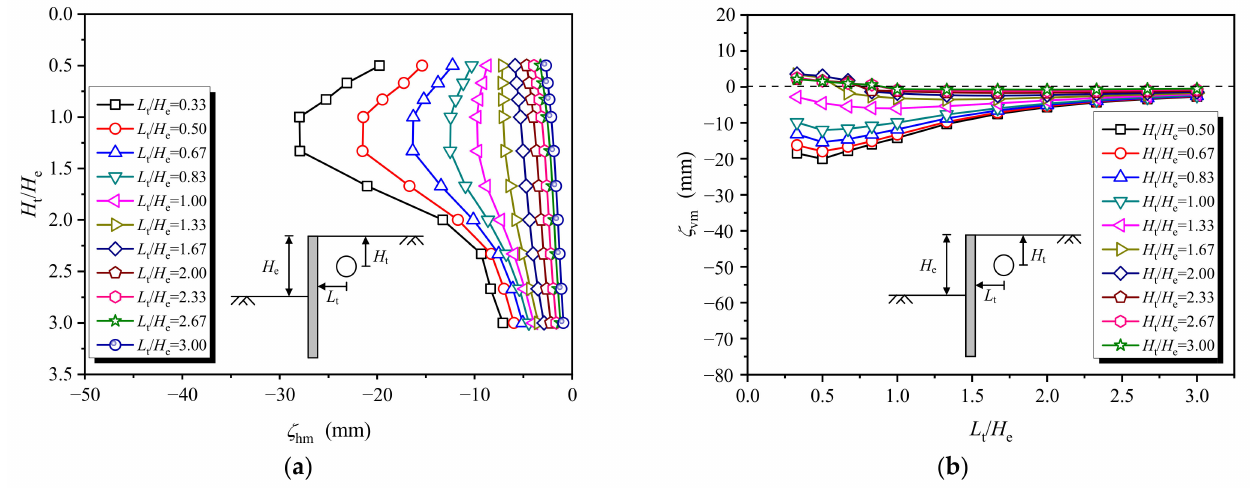
Figure 2. The maximum displacement of tunnels at different positions: ( a ) horizontal displacement; ( b ) vertical